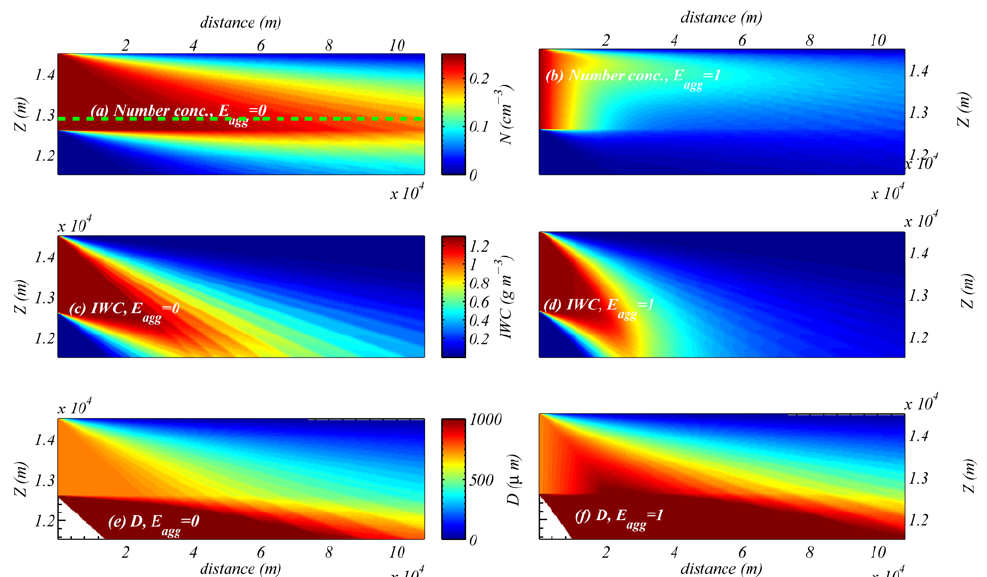
Fig. 13. Contour plots of a typical output from the sedimentation/aggregation model. Left plots are for E agg set to zero “no aggregation”, whereas right plots are for E agg set to unity. (a) and (b) show the time-height evolution of ice crystal number concentration, N (cm − 3 ); (c) and (d) show the time-height evolution of ice water content (IWC,gm − 3 ); and (e) and (f) show the time-height evolution of mass weighted mean diameter of the ice crystals in the distribution D (µm). Note that the green, dashed line in (a) is the approximate height of the flight tracks in the case study described, so is where the observations are compared with the model in Fig. 14.